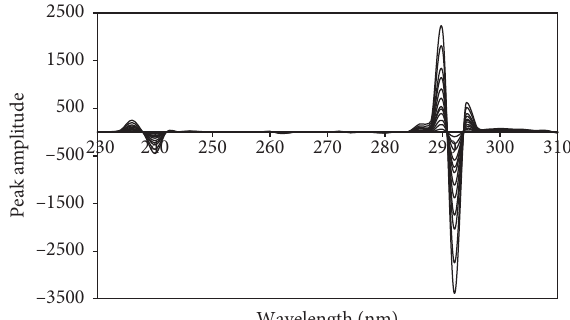
Figure 10: Successive derivative ratio spectra of 1, 3, 5, 8, 10, 12, 15,